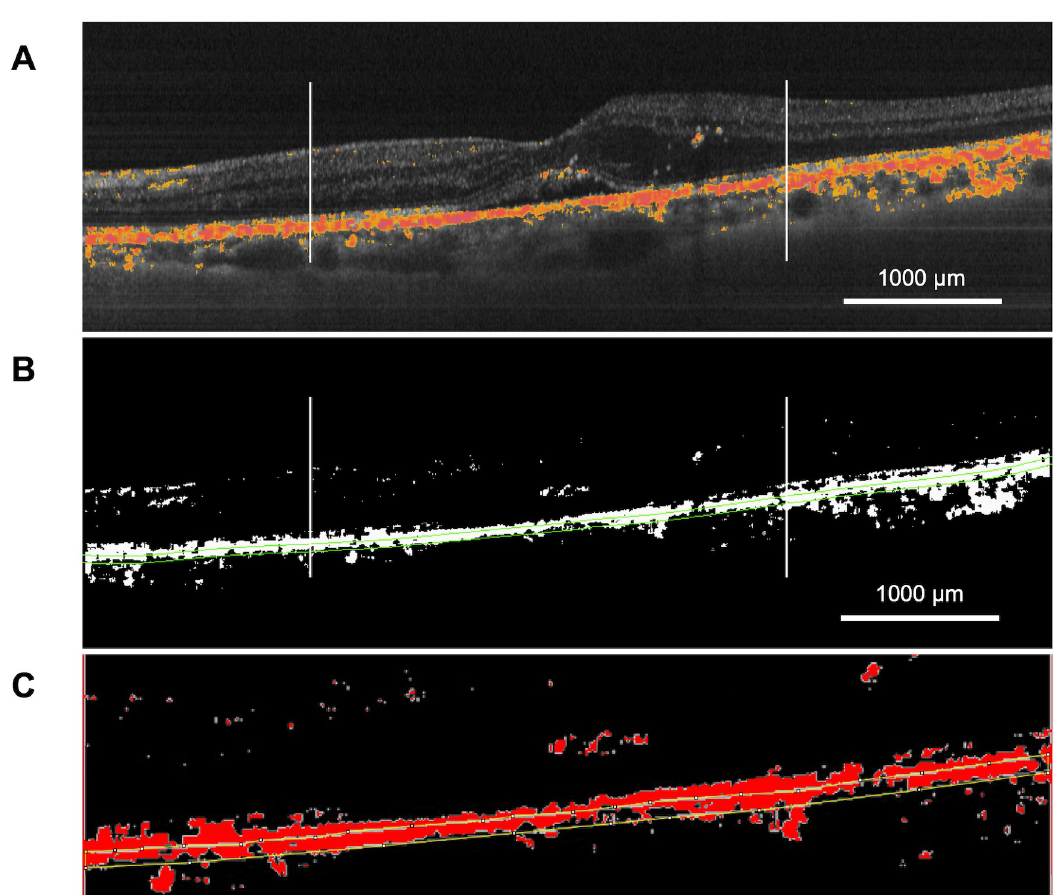
Fig 3. Assessment of entropy signals per unit area of RPE (pixel 2 ). The linear scan image obtained by scanning through the fovea within a 1500 μ m radius centered on the fovea was selected (delimited with two vertical markers traced at established distances; upper) and its imaging was binarized using Image J software (middle). Unit area of RPE was defined as 3 pixels above/below the line from automatic RPE segmentation (yellow lines), and the percentage of RPE entropy signals (red color) was calculated